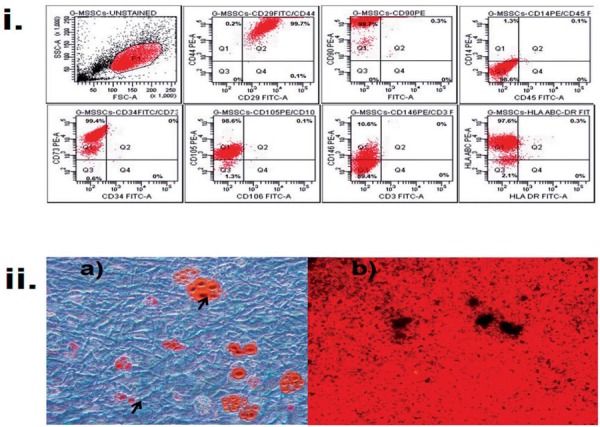
Gingival stromal stem cells (G-MSSCs) showed mesenchymal stem cell properties. i) CD44, CD29, CD106, CD105, CD146, and CD90 are mesenchymal stem cell surface receptors that were detected on G-MSSCs, except CD106. CD106 is a subpopulation of mesenchymal stem cells that addresses immunomodulatory properties. Hematopoietic stem cell surface receptors CD14, CD34, CD45; CD3, HLA DR were found to be negative. Expression of CD73 as a cluster of differentiation and HLA-ABC as an evidence of inflammatory condition was found to be positive ii) G-MSSCs have low adipogenic differentiation potential, whereas osteogenic differentiation was strong (a) Adipogenic differentiation: The black arrows show positively stained G-MSSCs for lipid vesicules with Oil Red O stain. (b) Osteogenic differentiation: The calcium granules were stained black with Alizarin Red stain in the osteogenic differentiation medium on the G-MSSCs (40x, Olympus CKX41, Tokyo, Japan)